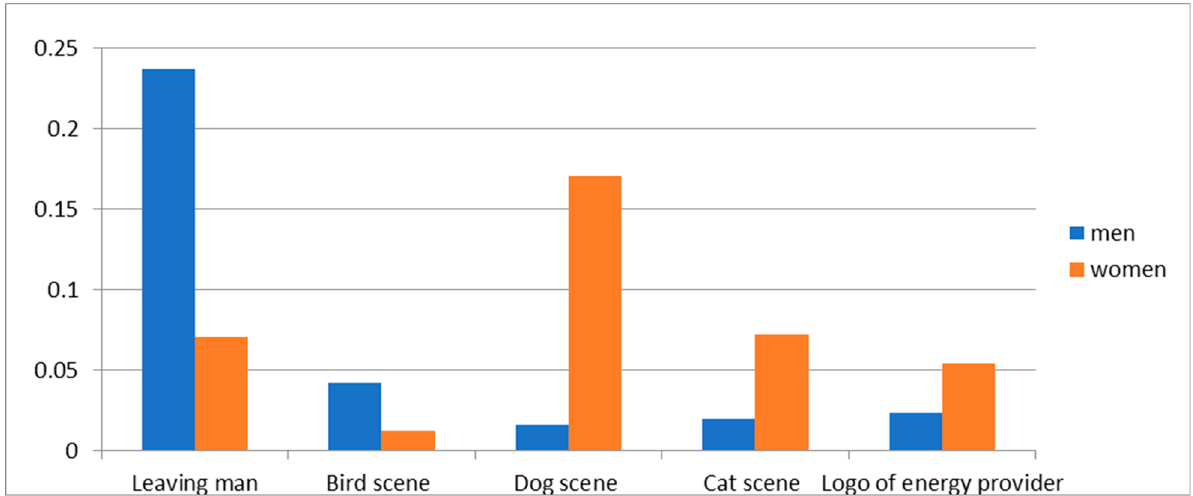
Figure 10. Standard deviations of the normalized male and female engagement indices for Energa media message.